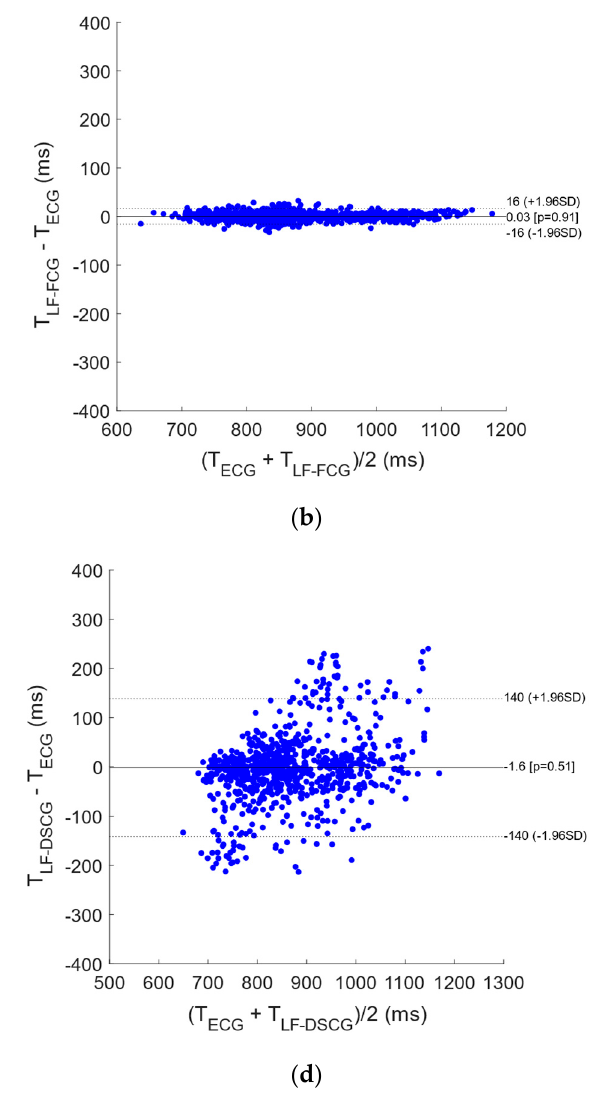
Figure 5. Statistical analyses on inter-beat intervals extracted from LF-FCG and LF-DSCG signals during respiration. ( a ) Results of regression and correlation analyses of LF-FCG vs. ECG; ( b ) results of Bland-Altman analysis of LF-FCG vs. ECG; ( c ) results of regression and correlation analyses of LF-DSCG vs. ECG; ( d ) results of Bland-Altman analysis of LF-DSCG vs. ECG.